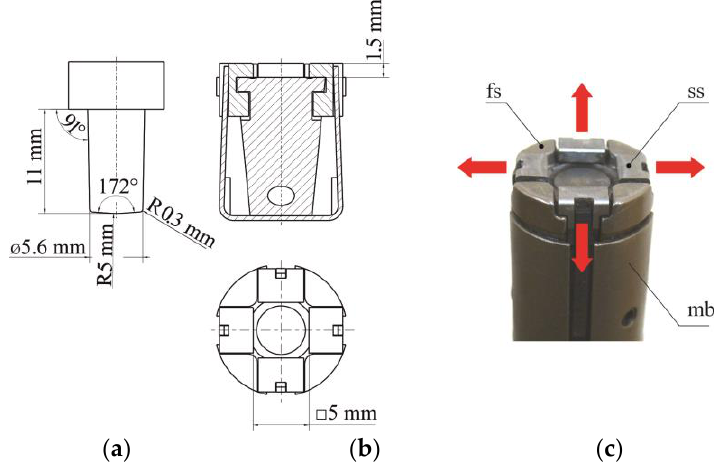
Figure 4. Clinch-riveting tools: ( a ) punch, ( b ) extensible die, ( c ) fixed and movable segments (fs—fixed segment, ss—sliding segment, mb—die base). Table 2. Sheet arrangements.